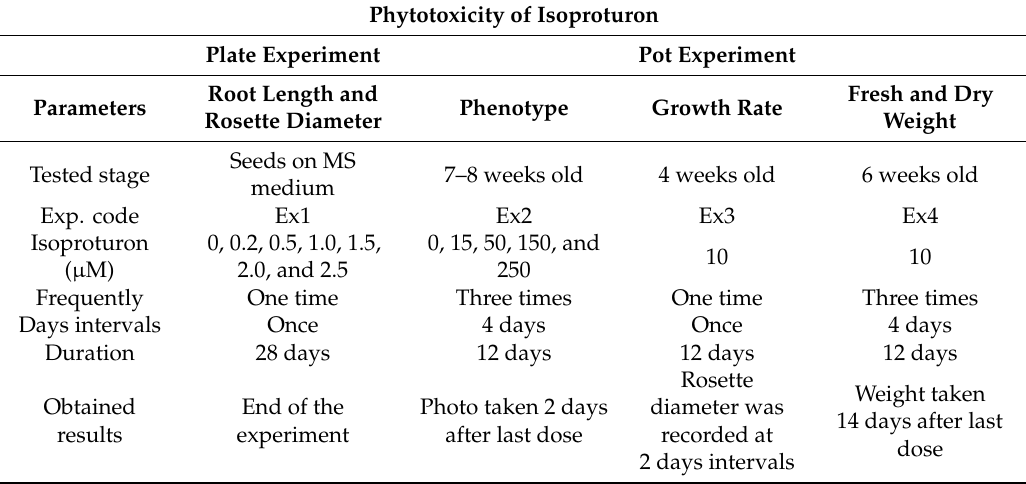
Table 1. Experimental design and treatment condition for the evaluation of isoproturon phytotoxicity on plant growth for wild and CYP1A2 transgenic Arabidopsis thaliana